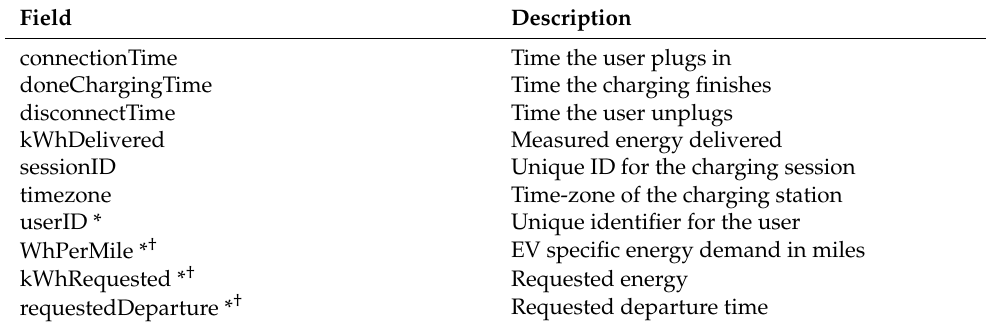
Table 1. Selected data fields of the ACN